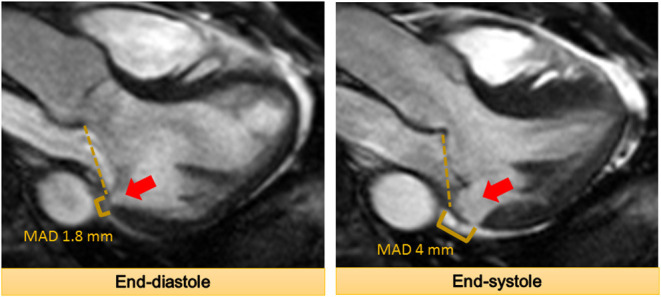
The mitral annular disjunction (MAD) at the inferolateral wall denoted by the arrow is demonstrated. It should be noted that MAD increases from end-diastole to end-systole.